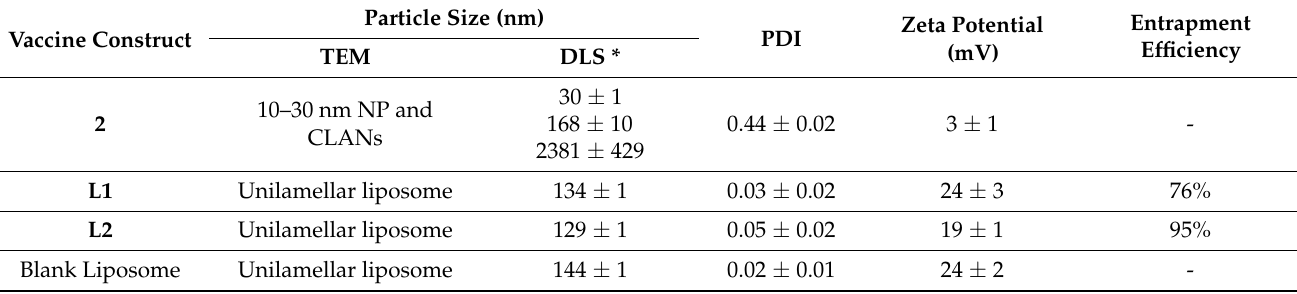
Table 1. Physicochemical characterization of compounds 1 , 2 , and encapsulated liposomes, L1 and L2